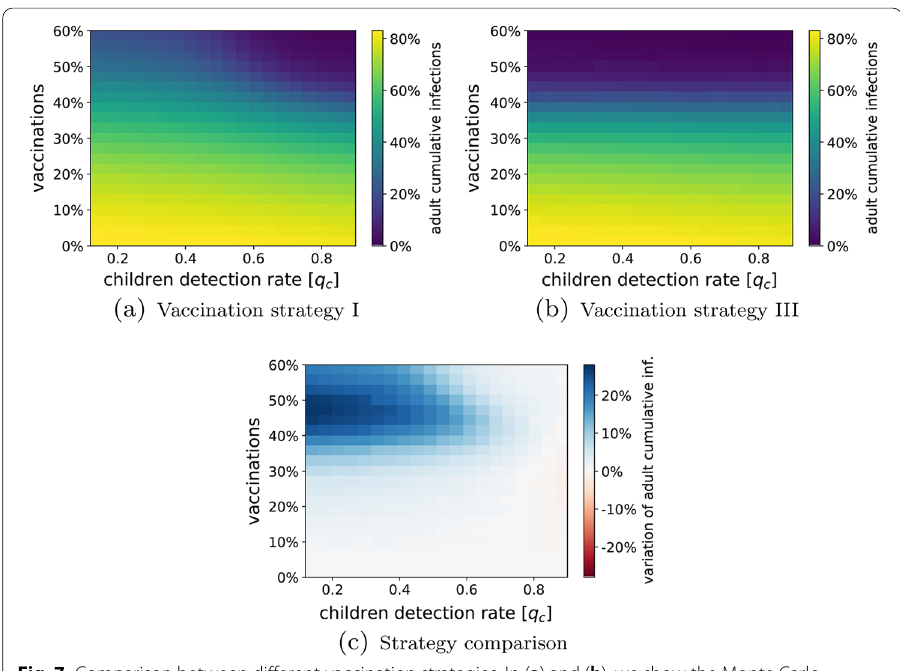
Fig. 7 Comparison between different vaccination strategies. In ( a ) and ( b ), we show the Monte Carlo estimation (over 100 independent simulations) of the cumulative number of infections among adults at the end of the epidemic outbreak, for different values of the fraction of eligible individual vaccinated ( V ) and different children detection rate ( q c ). In ( a ), we adopt vaccination strategy I, in which the vaccinated individuals are selected uniformly at random among the adult population. In ( b ), we adopt vaccination strategy III, in which the vaccination of adults belonging to large families is prioritized. In ( c ), the two strategies are compared, showing the variation in the cumulative numbers of infections between the two strategies. The parameters used in the simulations are listed in Table 2 and q a = 0.25 . All the simulations are done in Scenario III (Alpha variant), with the average infectiousness reported in Table